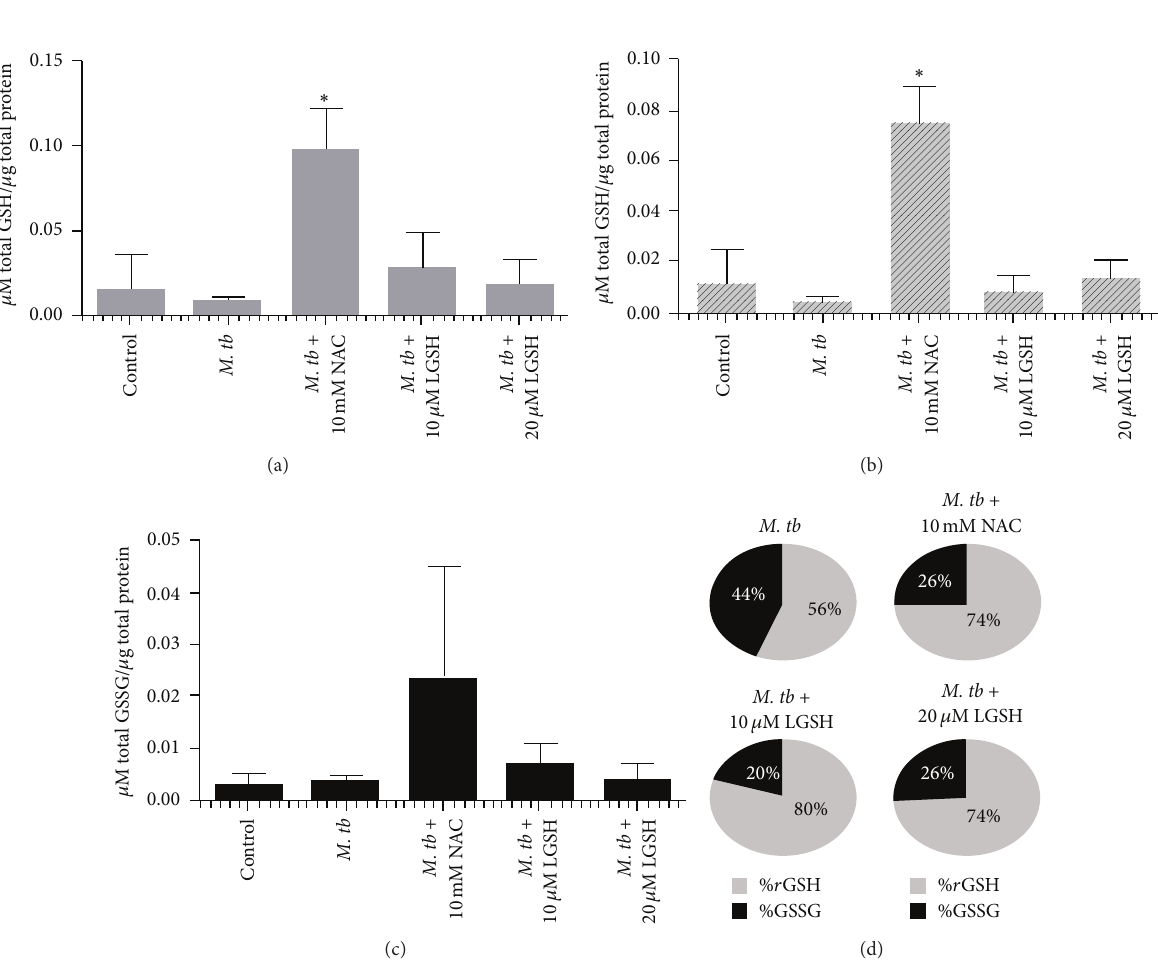
Figure 3: GSH measurements in neutrophils infected with H37Rv and treated with NAC and L-GSH ( 𝑛 = 5 ). GSH levels were measured in isolated neutrophils from healthy subjects that were infected in vitro with H37Rv and treated with GSH-enhancing agents such as NAC and L-GSH, by spectrophotometry using an assay kit. Briefly, H37Rv-infected neutrophils (3 × 10 5 ) were lysed at 24 hours after infection with ice cold 5% 5-sulfosalicylic acid dehydrate solution. Supernatants collected after centrifugation were analyzed for total GSH ((a) ∗ 𝑃 ≤ 0.05 ) and GSSG (c) as per manufacturer’s instructions. r GSH ((b) ∗ 𝑃 ≤ 0.05 ) was calculated by subtracting measured GSSG concentrations from the measured total GSH concentrations. All GSH measurements were normalized with total protein levels. Proteins in the cell lysates of neutrophils were measured by Bradford’s method using a Coomassie protein assay reagent. (d) illustrates ratio of r GSH to GSSG expressed as percentage of total GSH in neutrophil lysates. Graph shows mean ± standard